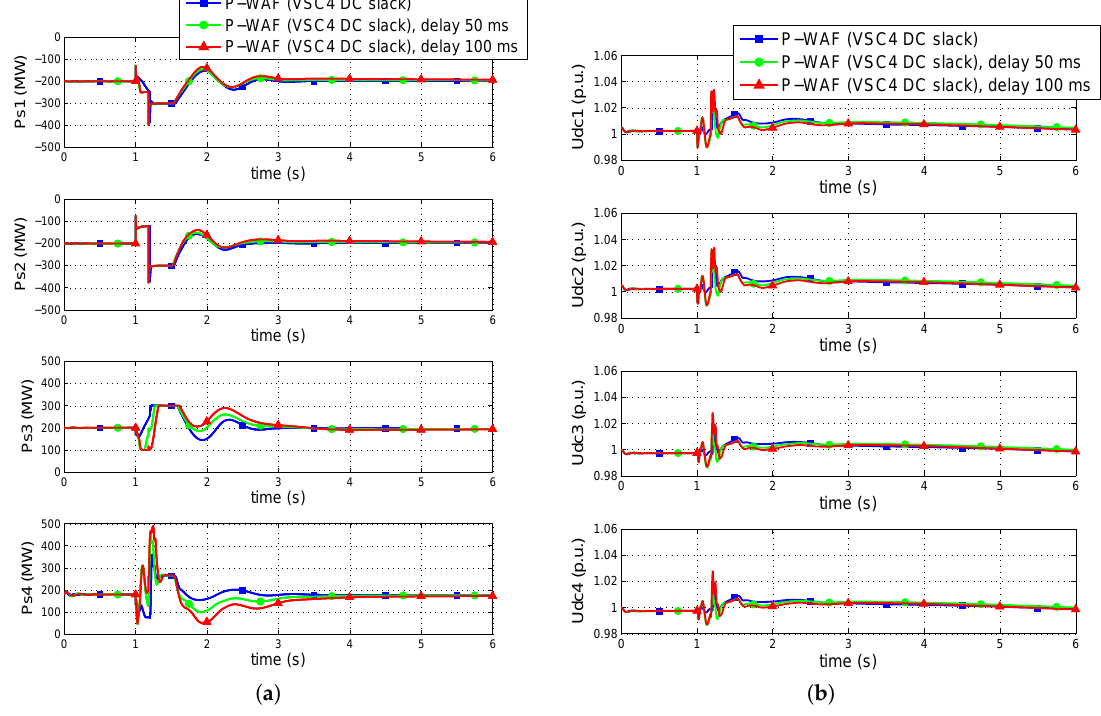
Figure 22. ( a ) P injections of the converters and ( b ) DC voltages.